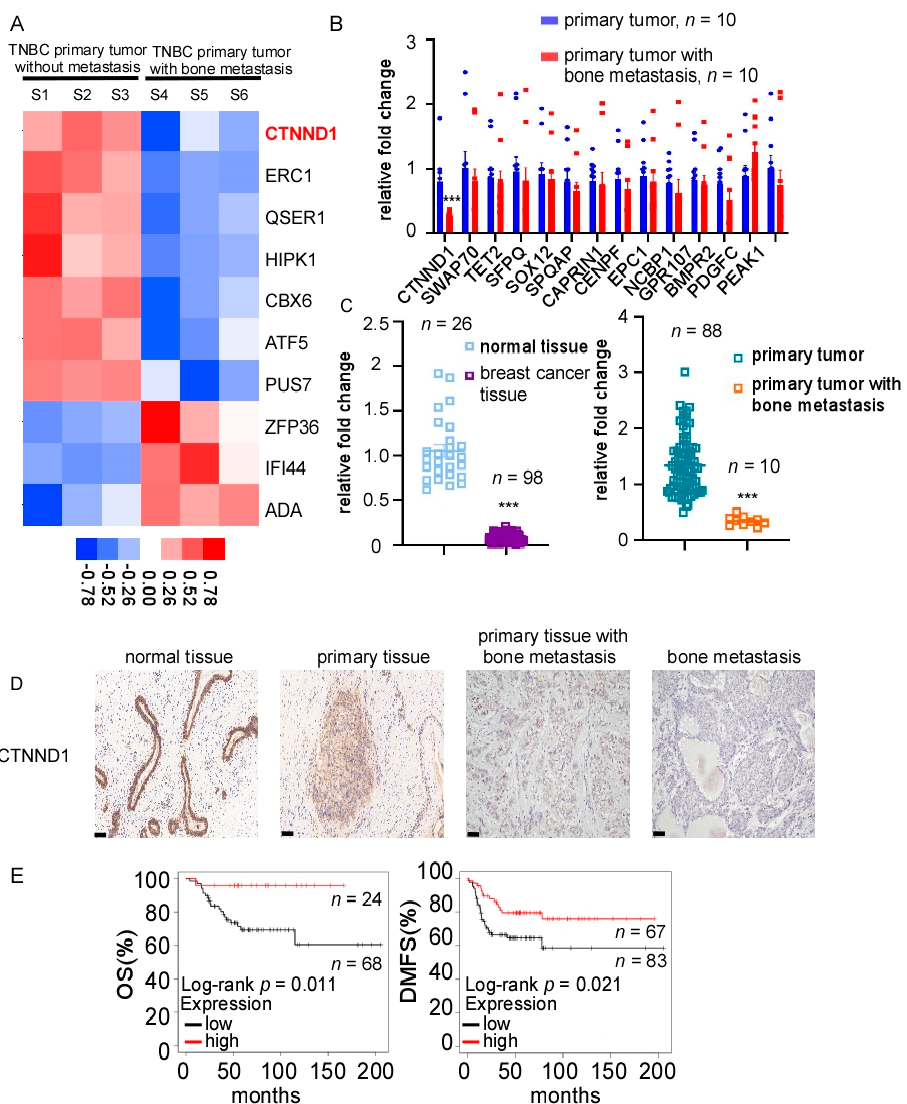
Figure 1. Identification of CTNND1 in TNBC with bone metastasis. ( A ) CTNND1 expression profile in TNBC with bone metastasis by high-throughput sequencing. Samples 1–3: TNBC without metastasis, samples 4–6: TNBC with bone metastasis. ( B ) Quantitative analysis of bone metastasis-related genes among the top one-hundred differentially expressed genes of high-throughput sequencing in primary TNBC tumor tissues without metastasis ( n = 10) and with bone metastasis ( n = 10). ( C ) Quantitative analysis of CTNND1 in normal breast tissues ( n = 26), breast cancer tissues ( n = 98), primary TNBC tumor tissues without metastasis, primary tumor tissues with bone metastasis ( n = 10) by qRT-PCR. ( D ). The expression of CTNND1 in TNBC tissues by IHC. Scale bar represents 50 μ m. ( E ) Kaplan–Meier analysis of the correlation between CTNND1 expression and overall survival (OS), distant metastasis-free survival (DMFS). All experiments were repeated at least 3 times. *** p < 0.005. Error bars indicate Standard Error of Mean (S.E.M.).